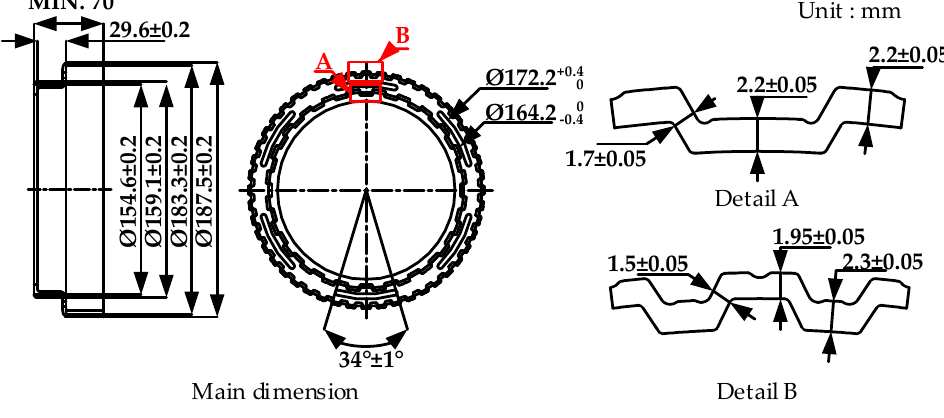
Figure 1. Dimensions of drum clutch.